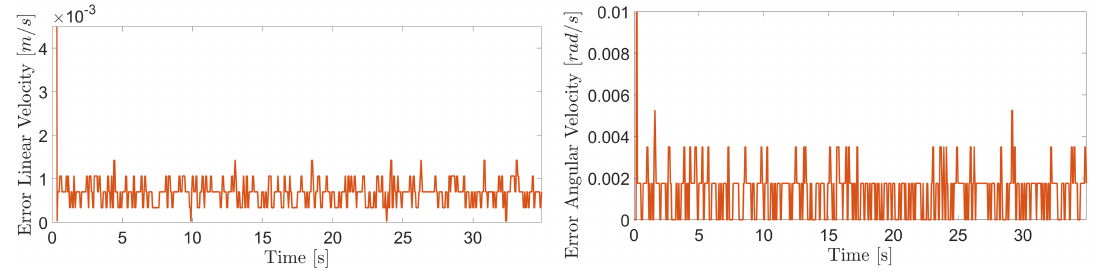
Figure 23. Linear and angular velocity errors during navigation of the climbing robot at 90 degree